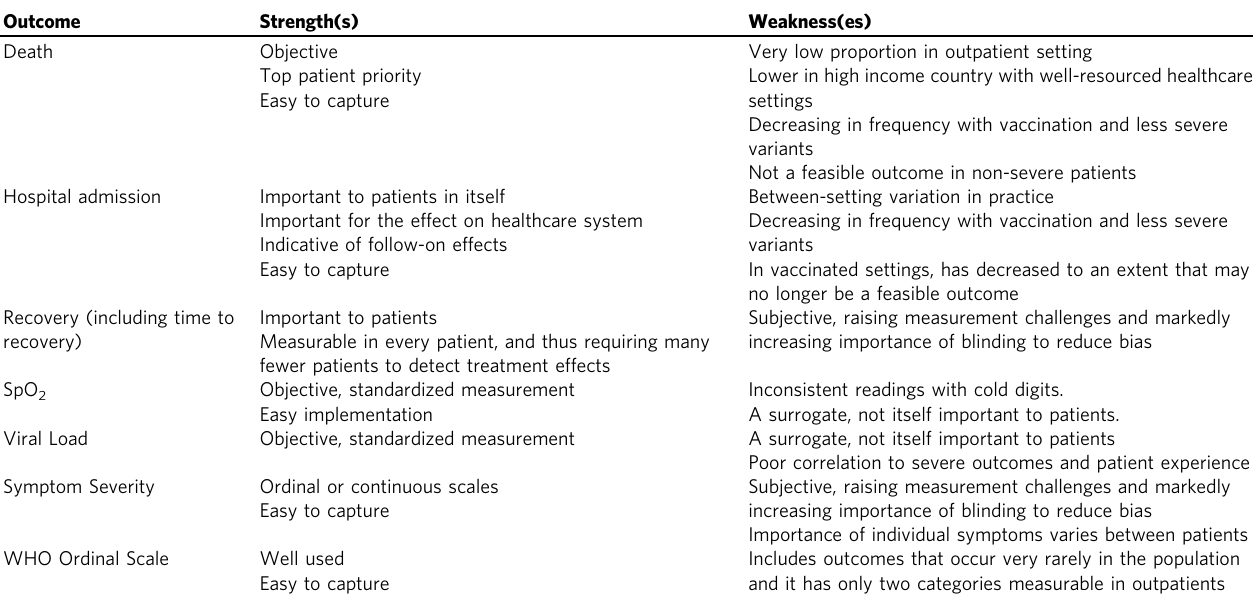
Table 1 Potential primary endpoints in COVID-19 outpatient clinical